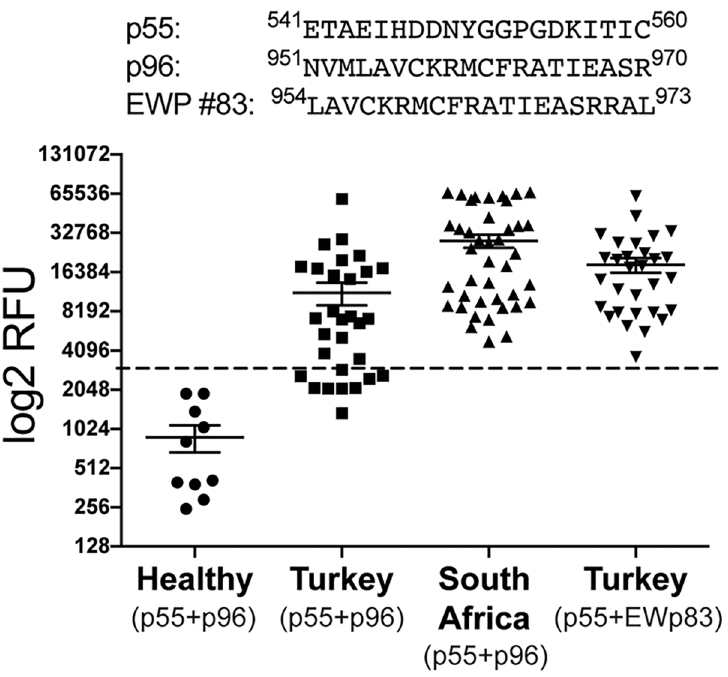
Fig 6. Dot-plot after combining intensities of serology with peptide p55 and p96 or EWP p83 (p96 + 3 aa). Control sera from healthy individuals, Turkish CCHFV survivors and South African CCHFV survivors. The dotted line represents the diagnostic cut-off value. P <